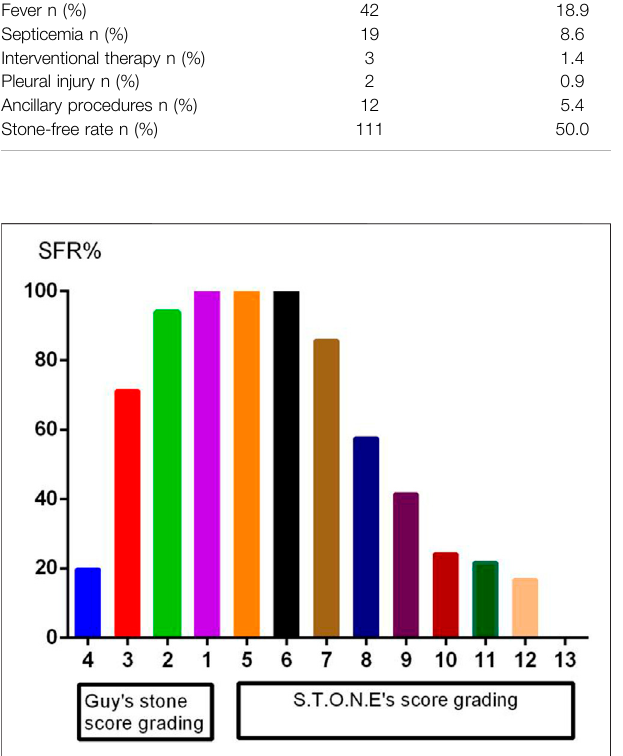
FIGURE2| Thestone-freerateineachsubgroupofGSSgradesandthe S.T.ON.E score